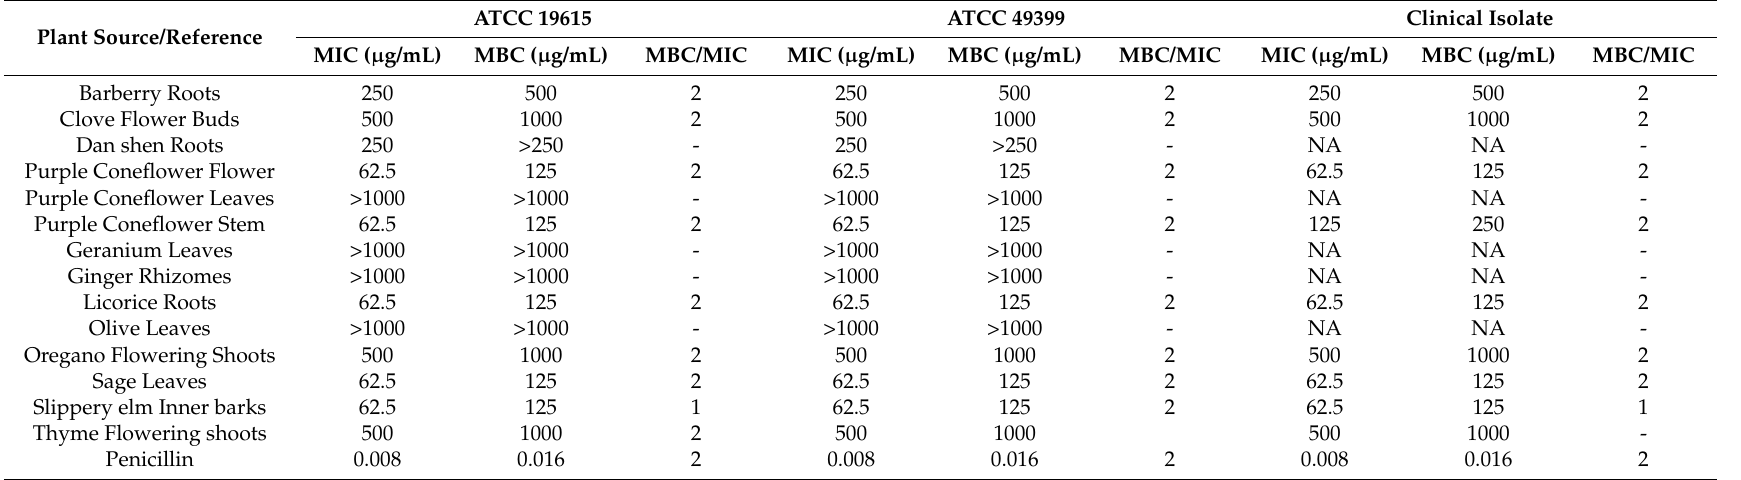
Table 2. Minimum inhibitory concentrations (MICs) and minimum bactericidal concentrations (MBCs) of selected ethanol extracts against Streptococcus pyogenes